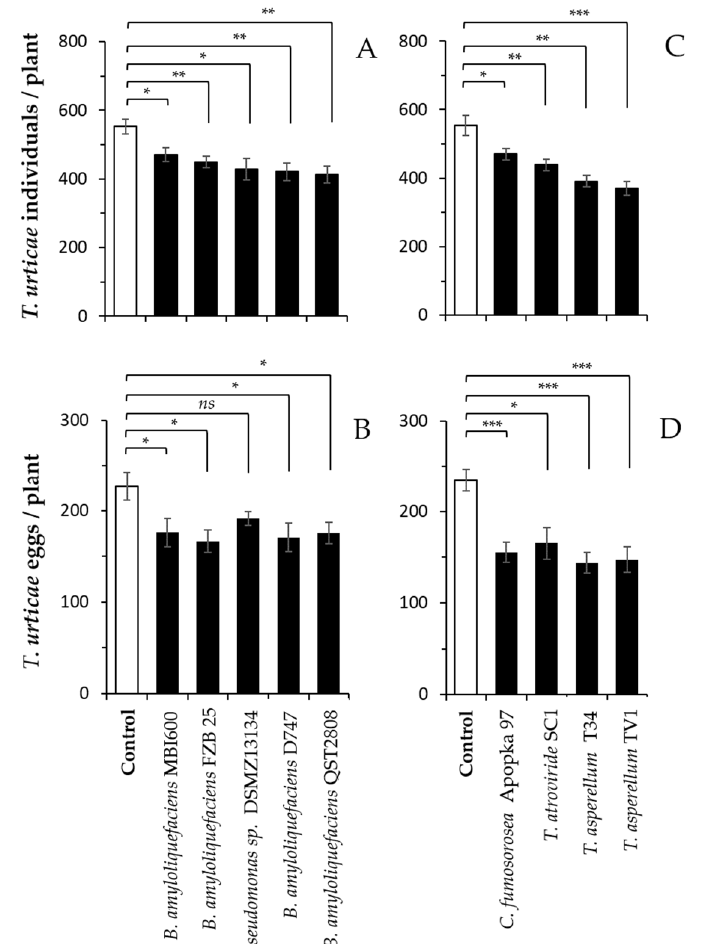
Figure 1. Plant-mediated effects of beneficial microbes on two-spotted spider mite performance in pepper. Plants were inoculated at transplantation and one week later with the different bacterial ( A , B ) and fungal ( C , D ) microbes. Shown are the means (± SE) of T. urticae individuals ( A , C ) as well as eggs ( B , D ) per plant 14 days following infestation with 45 adult females per plant ( n = 6 per treatment). In each panel, asterisks indicate significant differences between each treatment and the respective control ( t -test; * p < 0.05, ** p < 0.01, *** p < 0.001); “ns” indicates nonsignificant differences: p > 0.05).